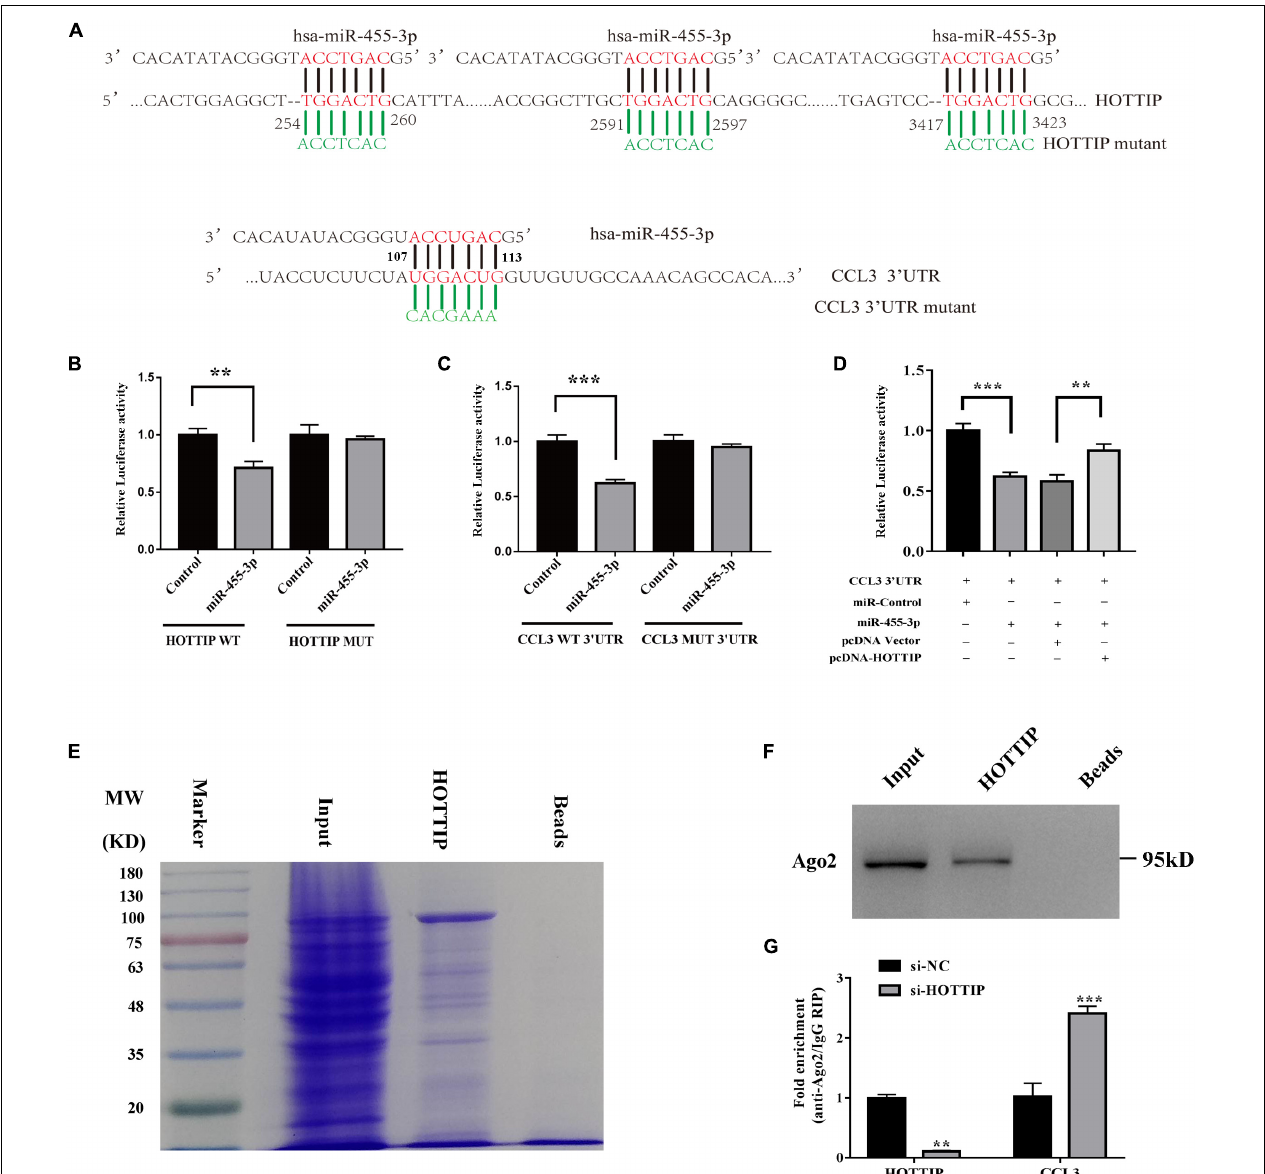
FIGURE 6 | HOTTIP may regulate chondrogenesis and degeneration through ceRNA mechanism in vitro . Putative binding site of miR-455-3p in HOTTIP and CCL3 3 (cid:48) -UTR were shown (A) . A luciferase reporter carrying the Luc-HOTTIP-wt or Luc-HOTTIP-mut (B) or Luc-CCL3-UTR-wt or Luc-CCL3-UTR-mut (C) in which the binding site of miR-455-3p was introduced into 293T cells along with negative miR-control (NC), miR-455-3p. The cells were harvested 48 h later for luciferase assays (B,C) . CCL3 3 (cid:48) -UTR and miR-455-3p constructs were cotransfected into HEK293 cells with plasmids expressing HOTTIP or with a control vector to verify the ceRNA activity of HOTTIP. Histogram indicates the values of luciferase measured 48 h after transfection (D) . HOTTIP was transcribed in vitro for RNA pulldown, and then the resolved by in-gradient gel electrophoresis was used for mass spectrometry analysis. These showed a possible interaction exists between HOTTIP and AGO2. Beads were used as control. MW, molecular weight marker (kDal) (E) . The binding of HOTTIP and AGO2 was examined by western blot (F) . RIP assay of the enrichment of AGO2 on HOTTIP and CCL3 transcripts relative to IgG in PHCs transfected with siHOTTIP (G) . The data shown represent the mean ± SD of three independent experiments. ∗∗ p < 0.01, ∗∗∗ p <